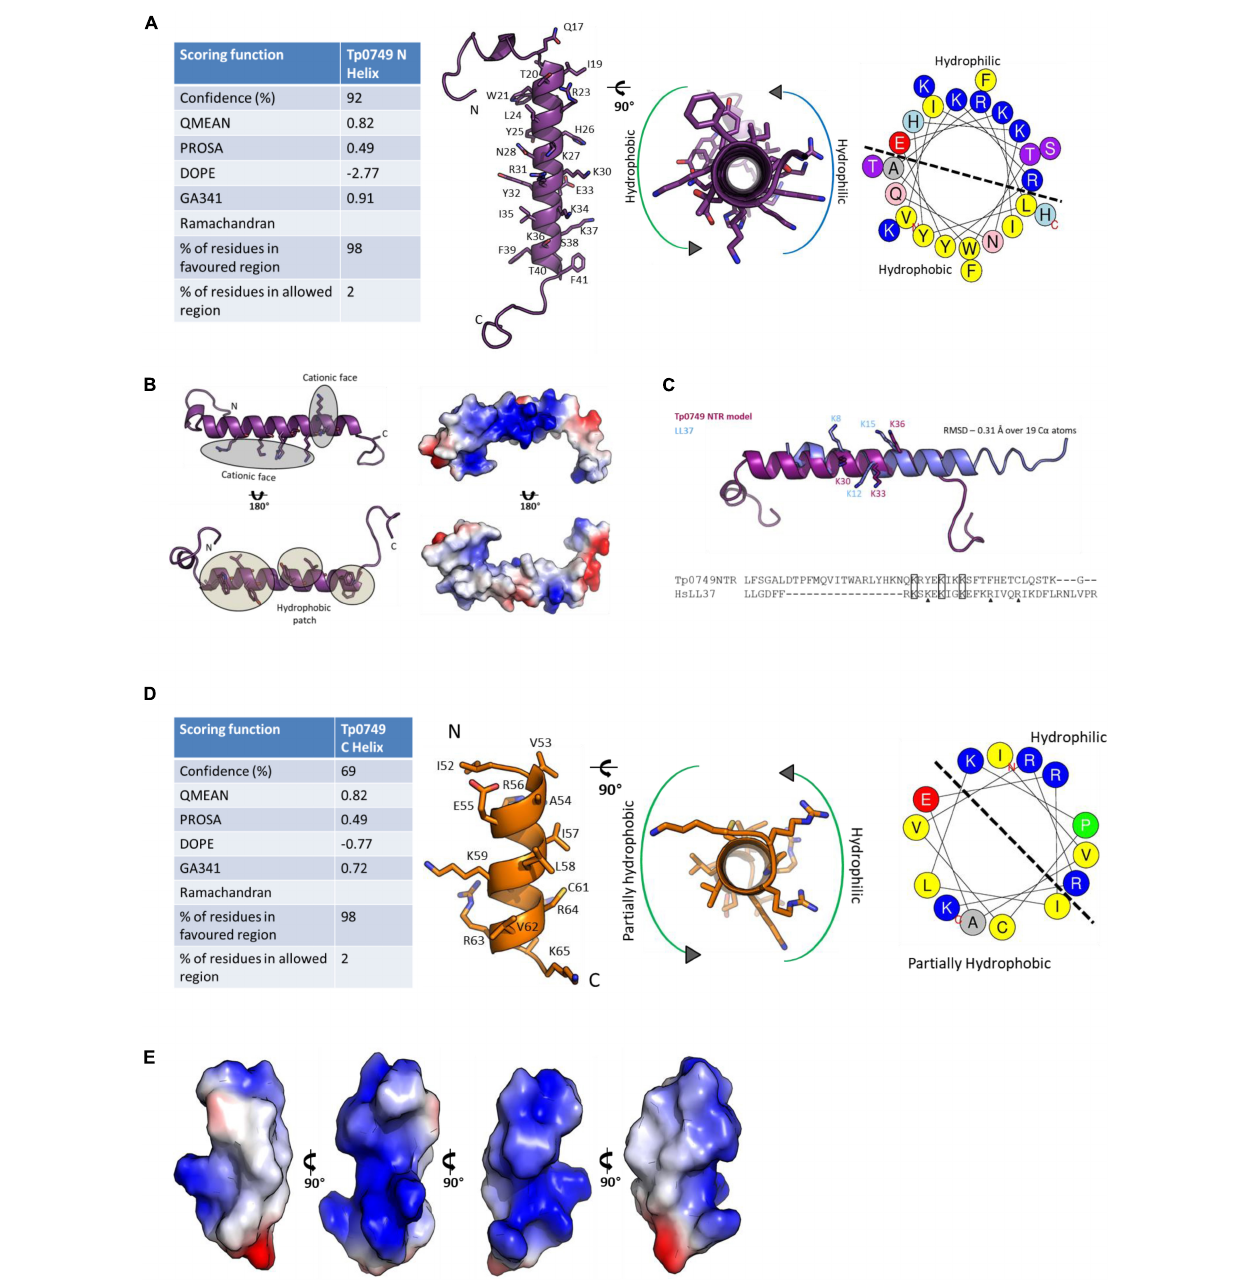
FIGURE 6 | Structure modeling of the candidate T. pallidum AMP, Tp0749. (A , Left): Table showing the scoring functions of the Tp0749 N-terminal model (residues P14-S48) generated by a combination of PEP-FOLD-2, Swiss-Model, Molsoft ICM, and Modeller. (Middle) Model ribbon structure of Tp0749 residues P14-S48 and rotated view showing amphipathicity. (Right) Helical wheel schematic of Tp0749 (P14-S48) generated using HeliQuest. Dashed line separates the hydrophilic/polar and hydrophobic/non-polar faces of the predicted alpha helix. (B) Ribbon and surface/charge distribution images of the Tp0749 (P14-S48) model showing one face of the alpha helix rich in positively-charged/polar residues (blue) and the opposing face rich in hydrophobic/non-polar residues (white). Red: negatively-charged/polar residues. (C) PROMALS3D was used to generate a structure-based comparative model of the Tp0749 N-terminal alpha helix model (P14-S48) using the structure of the known AMP, human cathelicidin LL-37 (PDB:5NMN) as a template. RMSD—0.31 Å over 19 C α atoms and 3/6 positively charged residues involved in binding target cell membrane lipids are conserved (indicated by rectangles; triangles show non-conserved residues). (D) Left: Table showing the scoring functions of the Tp0749 C-terminal model (residues I52-K65) generated by using a combination of PEP-FOLD-2, Swiss-Model, Molsoft ICM, and Modeller. (Middle) Model ribbon structure of Tp0749 residues I52-K65 and rotated view showing partial amphipathicity (red: negatively charged/polar residue side chains; blue: positively charged/polar residue side chains; yellow: cysteine residue side chain). (Right) Helical wheel schematic of Tp0749 (I52-K65) generated using HeliQuest. Dashed line separates the hydrophilic/polar and partially hydrophobic/non-polar faces of the predicted alpha helix. (E) Surface and charge distribution views of Tp0749 (I52-K65) (red: negatively charged/polar residues; blue: positively charged/polar residues; white: hydrophobic/non-polar residues).